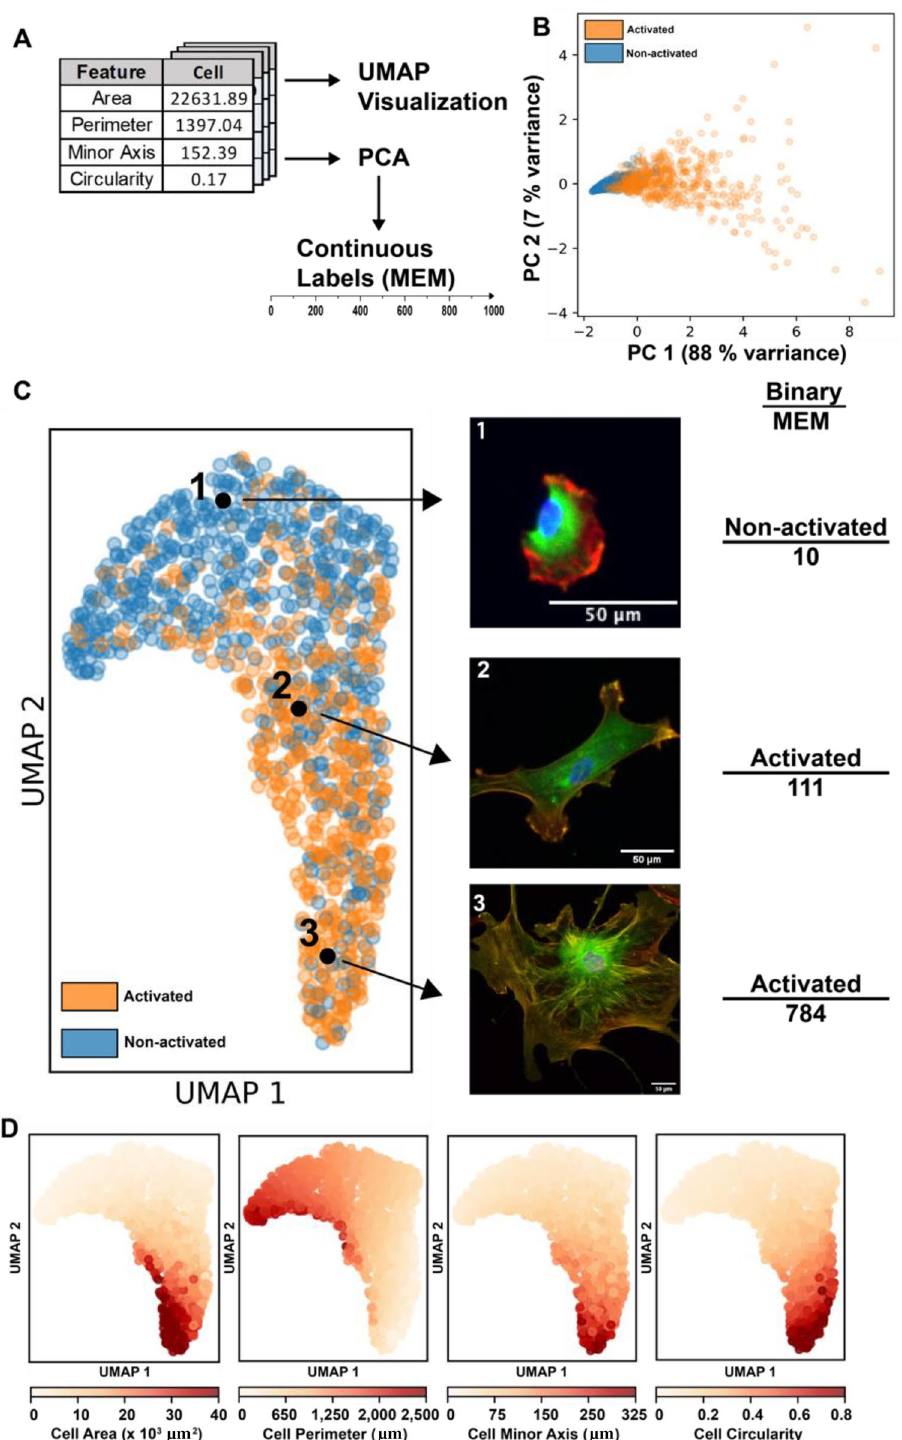
Figure 2. ( A ) Overview of the analytical pipeline. Cell feature vectors were first visualized using UMAP, then reduced using PCA and re-scaled to create a continuous label system. ( B ) 2D PCA reduction of the cell feature vector; PC 1 contained 88% of the variance and was used to create the MEM labels. ( C ) UMAP reduction of the manually engineered features of all 1104 cells, highlighting cells of different activation levels, with both their binary and MEM label. ( D ) Labeling the UMAP reduction by cell features (cell area, cell perimeter, cell minor axis, and cell circularity) helps to understand how cells are organized in the